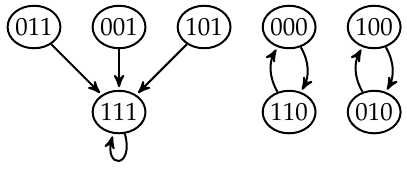
Figure 5. Graph associated with F ( x 1 , x 2 , x 3 ) = ( x (cid:48)